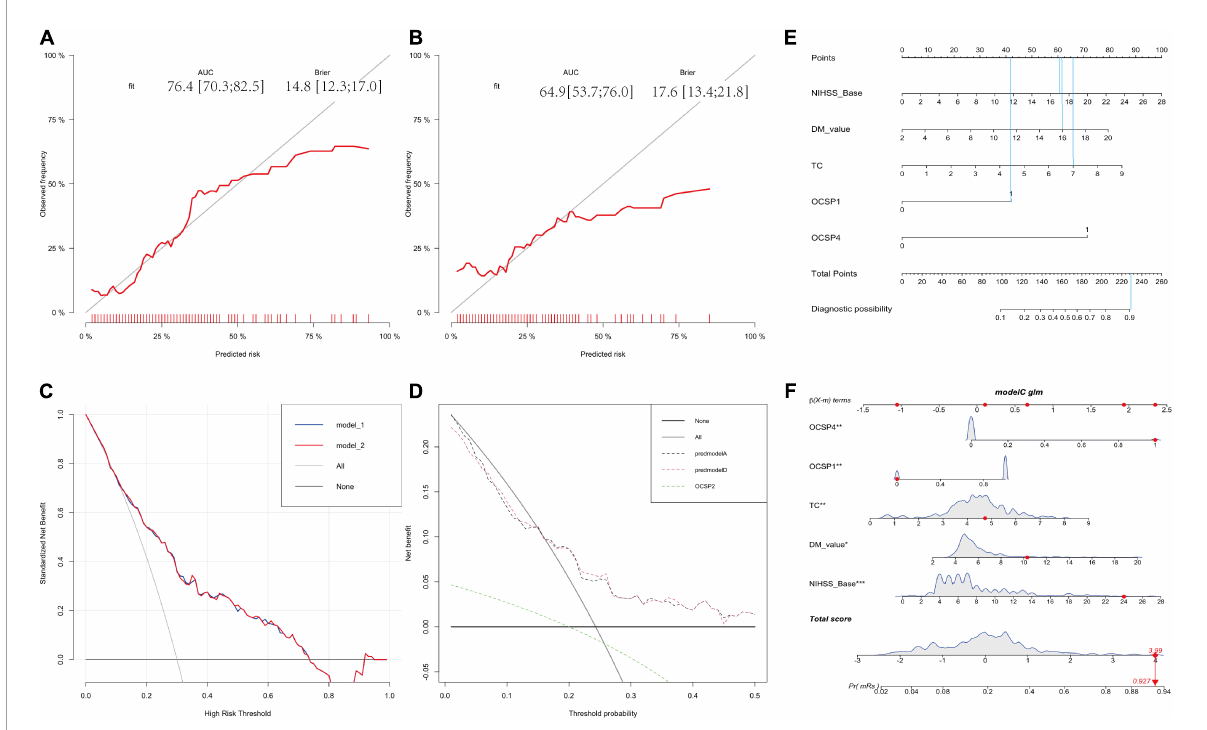
FIGURE3 Calibration and DCA validation for the logistic models for the in-house dataset. (A,B) Calibration plot for the developing and validating the in-house data which show the AUC and Brier value. (C,D) The DCA validation for the developing and validating the in-house data which show both models have good net benefits. (E) The nomogram for distinguishing risk factors. (F) Prognostic GLM for stroke patients with intravenous thrombolysis. Model 1 is the 6-factor logistic model (added with OCSP2) and Model 2 is the 5-factor logistic model in the developing in-house dataset; Premodel A is the 6-factor logistic model (added with OCSP2) and Premodel B is the 5-factor logistic model in the validating in-house